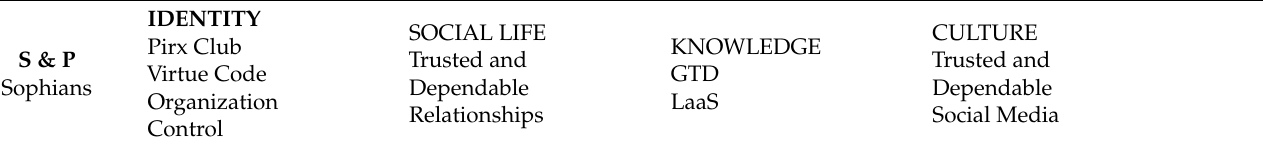
Table 3. Illustrating the dependable and resilient smart city design specification